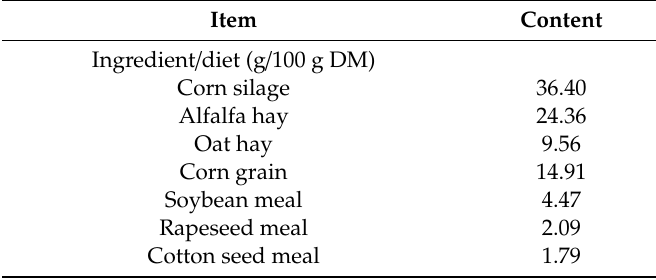
Table A1. Ingredient and nutrient concentrations of experimental